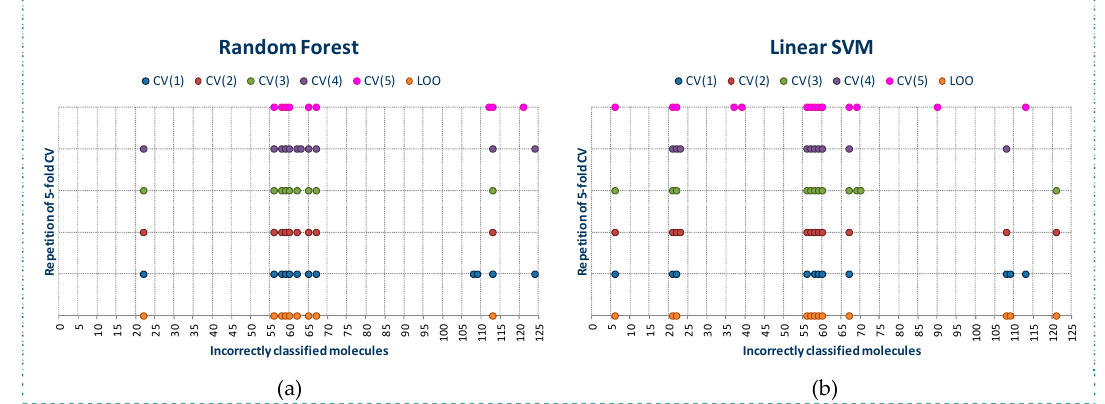
Figure 1. Outliers detected by RF ( a ) and SVM ( b ) in the building of classification models for YES1 dataset using LOO and 5-fold cross-validation (5 models were built).